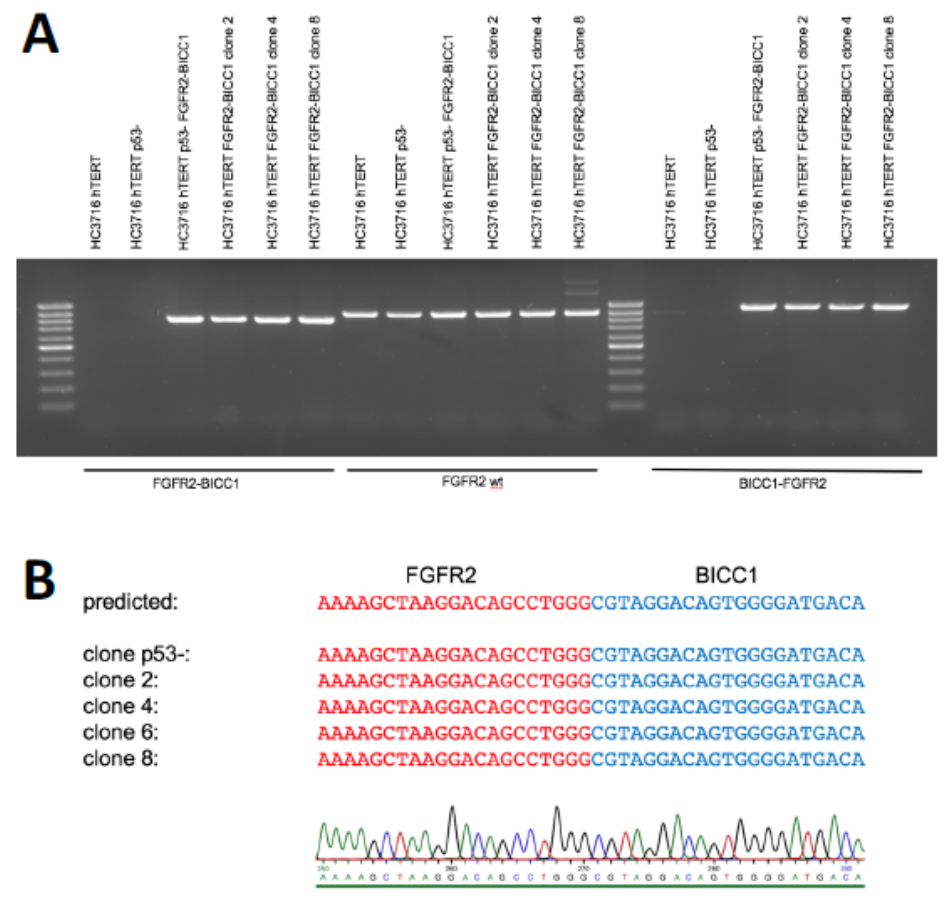
Figure 4. DNA validation of the genomic breakpoint junction of the inversion. ( A ) DNA was isolated from the clonal cell lines, and the FGFR2–BICC1 and BICC1-FGFR2 breakpoint junctions were detected PCR. The FGFR2 WT allele around the CRISPR targeting site was amplified as a control. ( B ) Sanger sequencing of the genomic breakpoint